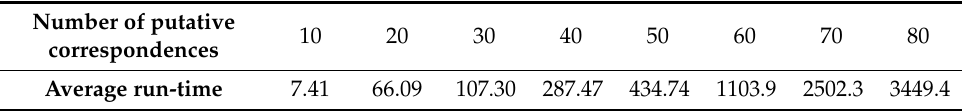
Table 2. Run times of our method with respect to the different numbers of putative correspondences for the different range image pairs (unit: